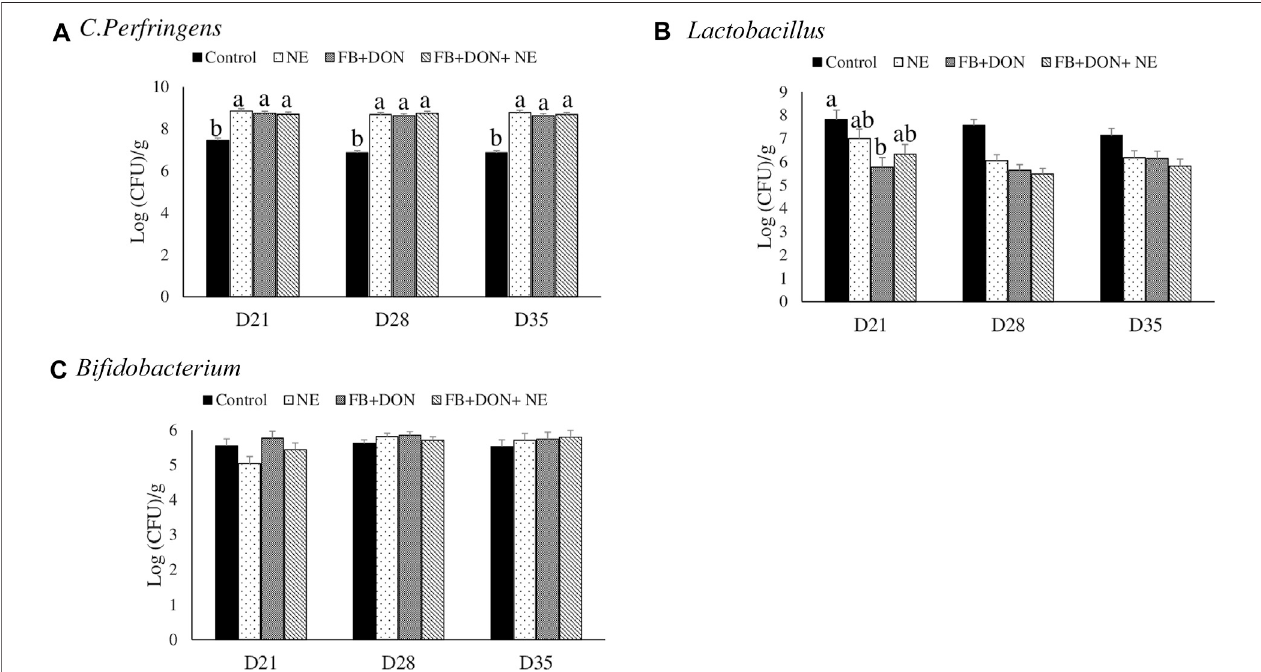
FIGURE 7 | Effect of subclinical dose of FB + DON and E. maxima/C. perfringens challenge on C. perfringens , total Lactobacillus, and total Bi fi dobacteria loads in the cecal content. Day-old chicks were distributed into four treatment groups: control, necrotic enteritis (NE), fumonisin + deoxynivalenol (FB + DON), and FB + DON + NE groups. Birds in theNE and FB + DON +NE groups received 2.5 ×10 3 Eimeriamaxima oocystper bird on day 14. All birdsreceived 1×10 8 CFU/bird of Clostridium perfringens on days 19, 20, and 21. Cecal content was analyzed for C. perfringens , (A) total Lactobacillus, (B) and total Bi fi dobacteria (C) through PCR. Bars (+SEM) without a common superscript differ signi fi cantly ( p < 0.05). n = 8 (8 pens of 15